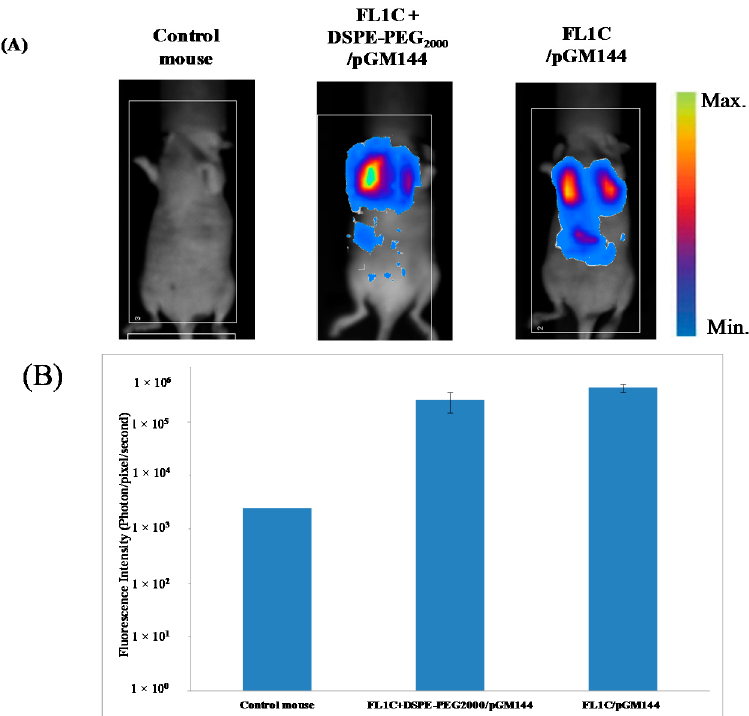
Figure 6. In vivo localization of luciferase ( luc ) expression reported at 24 h after intravenous delivery of FL1C-based lipoplexes ( A ); and Bioluminescence quantification ( B ).